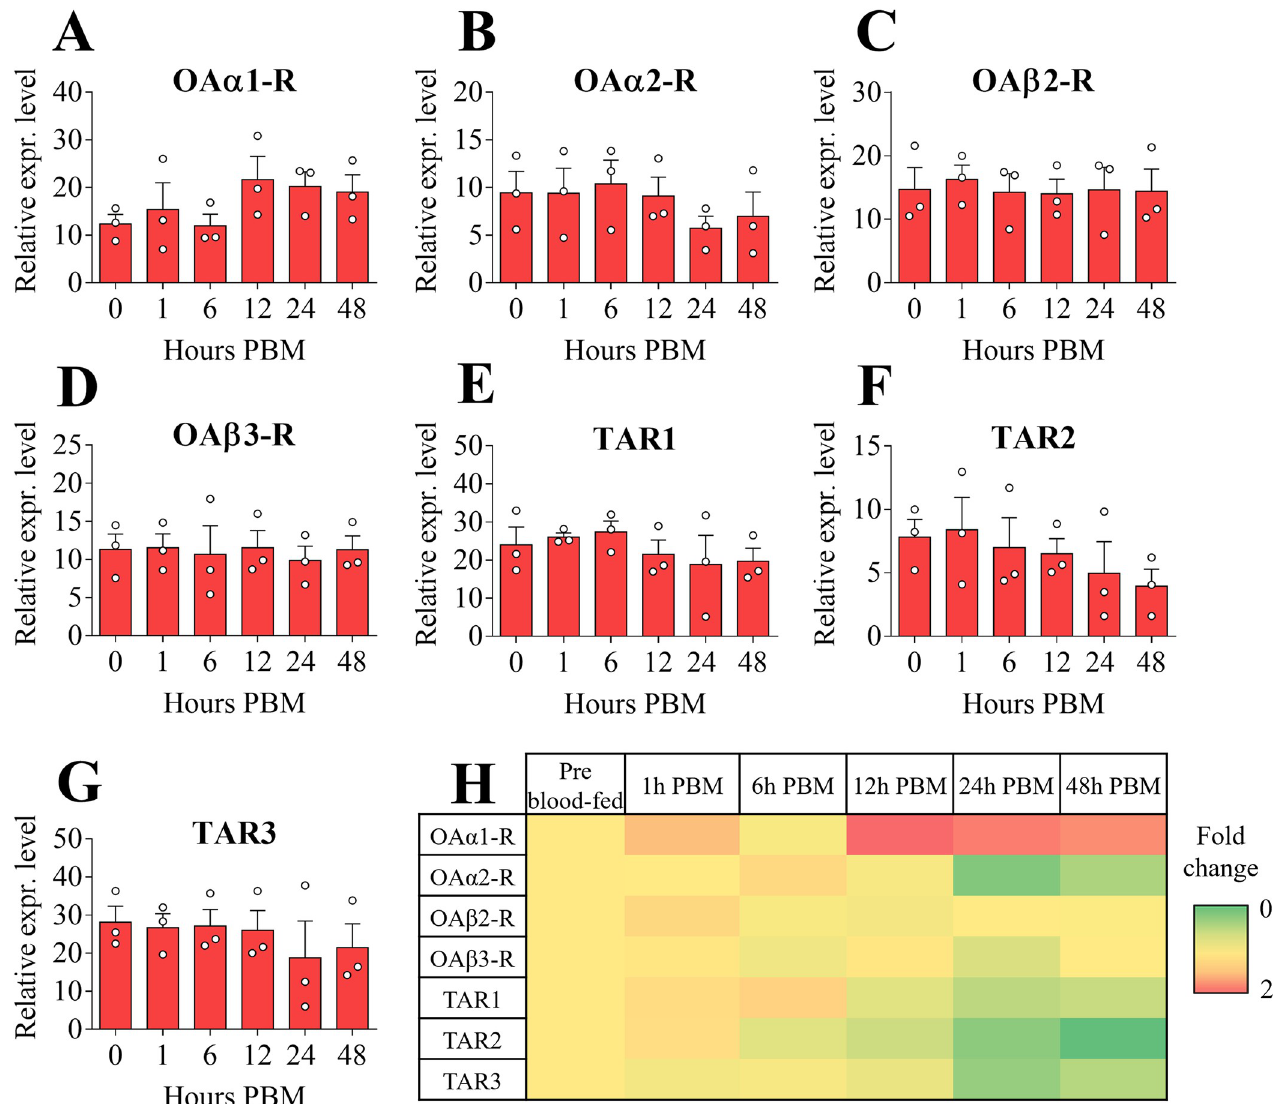
Fig 4. Expression patterns of OA and TA receptor transcripts among female adult A . aegypti brain post blood meal (PBM) time points. AaOA α 1-R ( A ), AaOA α 2-R ( B ), AaOA β 2-R ( C ), AaOA β 3-R ( D ), AaTAR1 ( E ), AaTAR2 ( F ) and AaTAR3 ( G ). Normalizing receptor expression levels in pre blood-fed condition to 1, a heat map was also assembled ( H ). Data represent means ± SEM of three biological replicates. Statistical analysis was performed according to one-way ANOVA followed by multiple comparisons Bonferroni post hoc